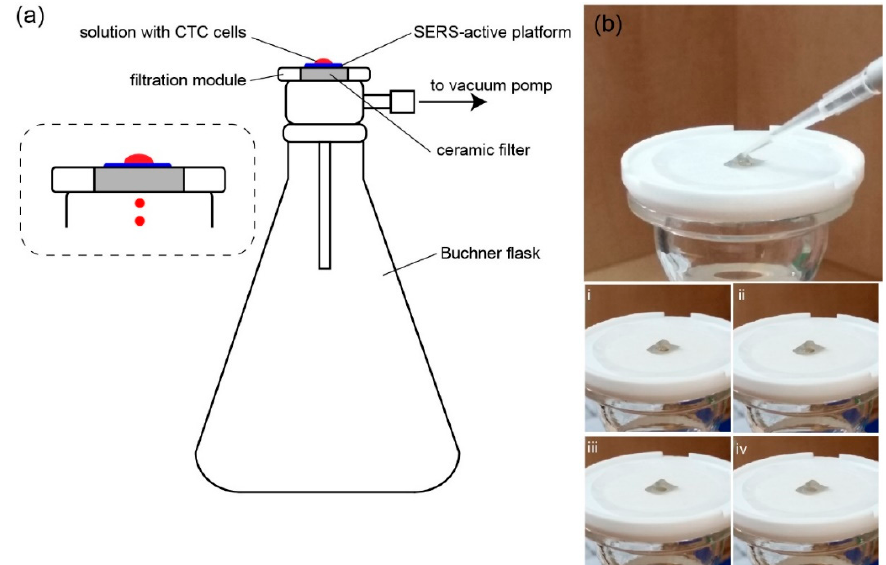
Figure 3. ( a ) The scheme of capturing circulating tumor cells (CTCs) from the blood sample. The system involves: a vacuum pump, Buchner flask, and filter funnel. The surface-enhanced Raman spectroscopy (SERS) platform was placed on the filter funnel and a droplet of blood spiked with CTCs was put on the platform. After turning on the pump, the liquid was sucked through the mat to the flask, whereas the CTCs remained on the surface of the SERS platform. ( b ) Filtration process of the fluid with the CTCs. The setup consists of a ceramic filter and SERS-active platform placed in the very center. After pipetting a small amount of fluid (top) with CTCs, the vacuum pump is turned on and the blood passes through the mat and the ceramic filter to the Büchner flask, whereas the CTCs stay on the SERS-active platform (steps